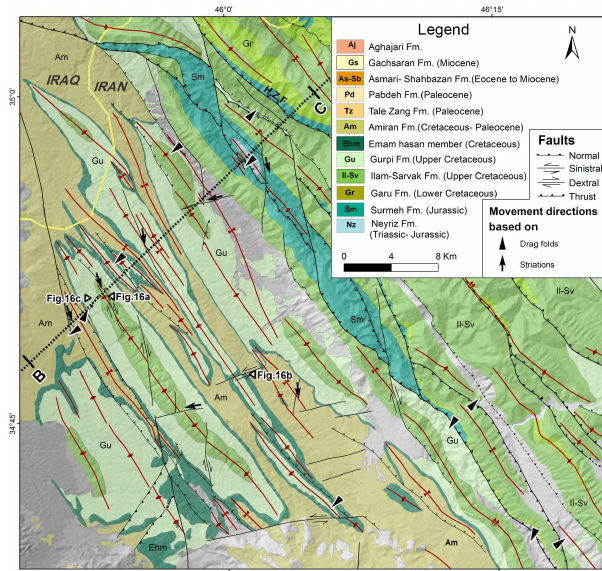
Figure 15. Structural map of the Salas area. For the location of the map area refer to Fig. 3. The cross section line that goes through points B and C is presented in Fig. 6.